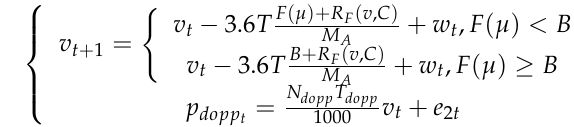
Figure 3. Wheel Hall speed sensor and installation example: ( a ) wheel Hall speed sensor; ( b ) installation example.